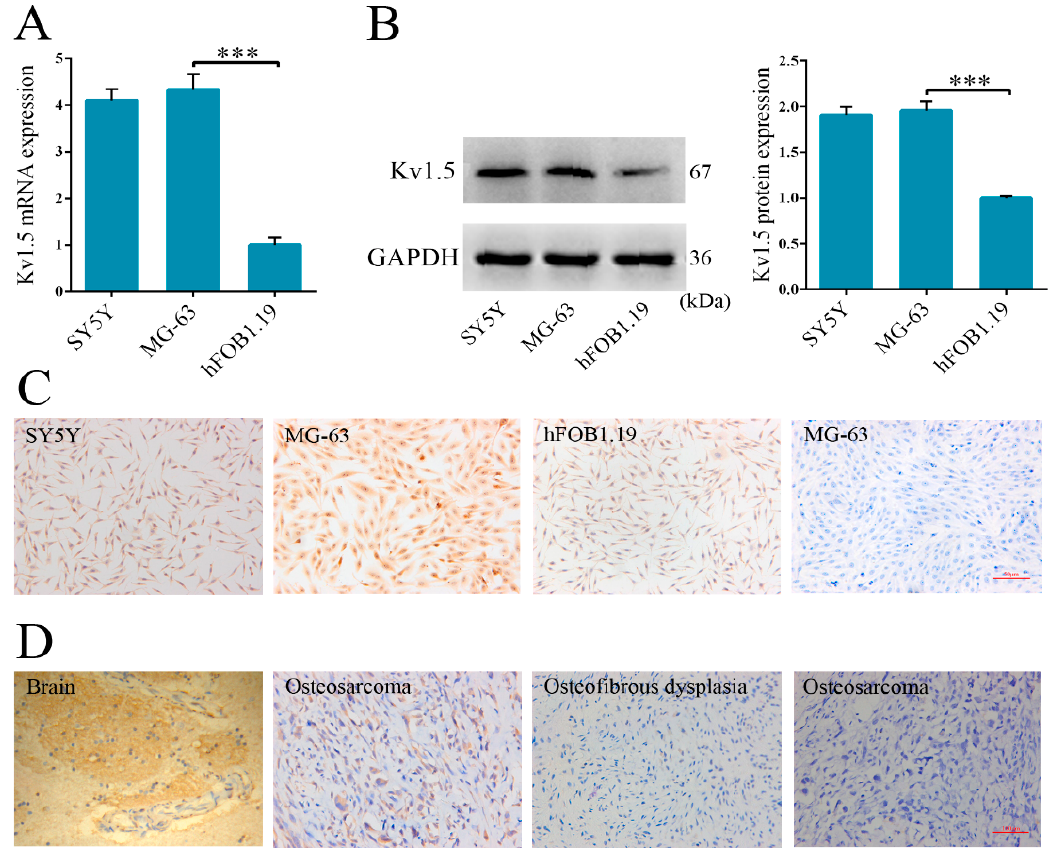
Figure 1. Aberrant expression of Kv1.5 in osteosarcoma. ( A ) RT-PCR was performed to measure Kv1.5 mRNA levels in SH-SY5Y, MG-63 and hFOB 1.19. β -actin was used as the internal standard; ( B ) Protein expression of Kv1.5 was measured in SH-SY5Y, MG-63, and hFOB 1.19 cells by Western blot analysis. GAPDH was used as the internal standard; ( C ) Immunohistochemistry staining for Kv1.5 in MG-63 cells. Images were captured using an Olympus light microscope equipped with a CCD color camera; Scale bar = 50 μ m; ( D ) Immunohistochemistry of Kv1.5 in human brain, osteosarcoma and osteosfibrous dysplasia samples. *** p < 0.001; Scale bar = 100 μ m